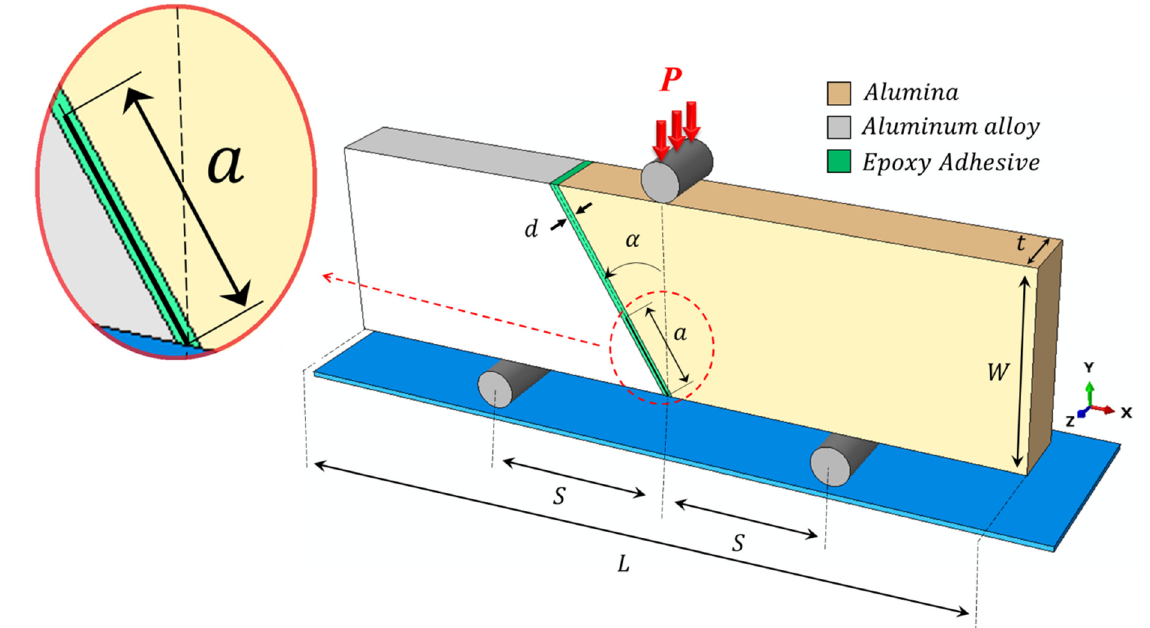
Figure 1. Geometry and loading configuration of bi-material fracture test geometry joined by an adhesive and containing an inclined edge crack of length a.